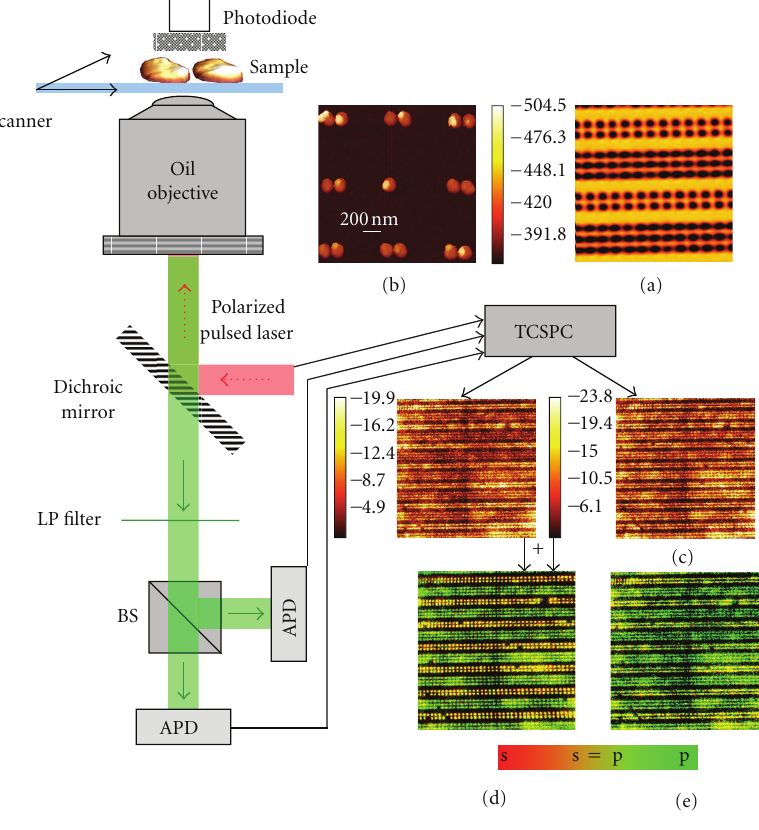
Figure 5: Confocal microscope with single-molecule detection capability. A pulsed laser serves as the excitation light incident on the sample via a dichroic mirror and an oil immersed objective (numerical aperture 1.3). The luminescence EPI-generated by the sample is collected through the objective, and then directed through the dichroic mirror and long-pass (LP) filters toward the detectors. The detectors are avalanche photodiodes (APDs), detecting the two crossed-polarization components of the luminescence. These components are formerly separated by a polarizing beam splitter (BS) and recorded via a time-correlated single-photon counting (TCSPC). A photodiode is also placed above the sample, to collect simultaneously the transmitted field as in (a). The piezo scanner, associated with the feedback controller, allows acquiring point-by-point images in the xy -plane of the sample, as illustrated by the two images in (c). A composed image from the images in (c) is then generated for p- (inset d) and for s-polarized (inset e) excitation. The inset (b) is a selected AFM image of one of the explored